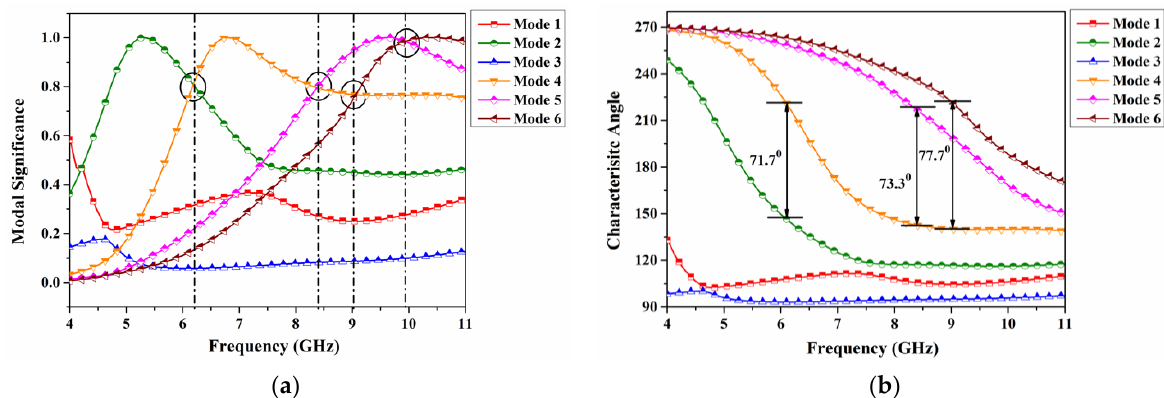
Figure 2. Modal parameters: ( a ) Modal significance and ( b ) Characteristic angle.